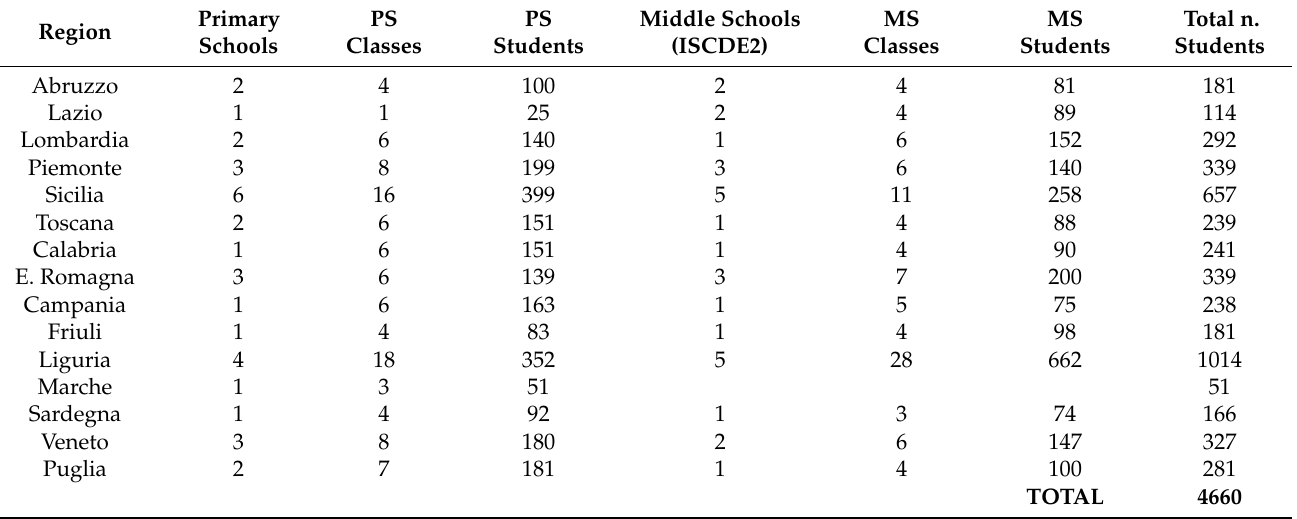
Table 3. Schools involved in the Salvina and the flood educational online gaming experience.